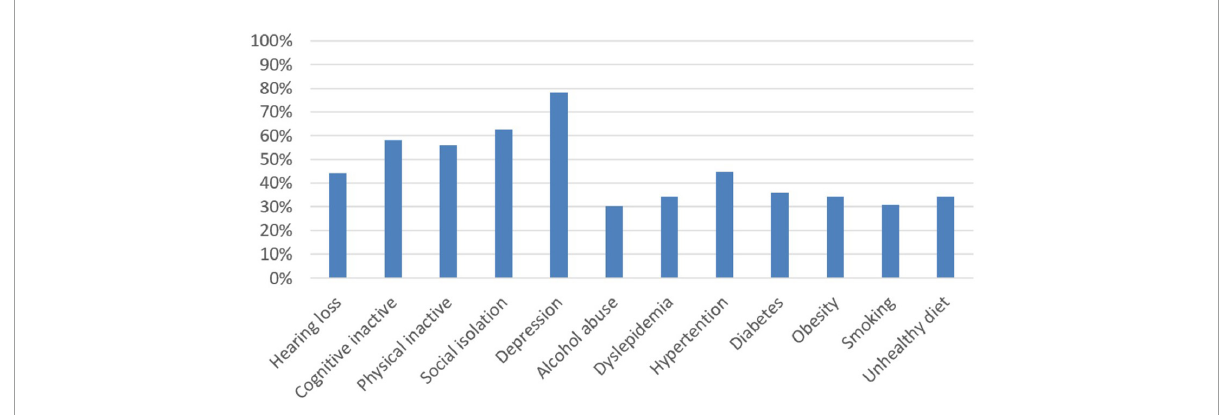
FIGURE1 Proportion of participants who identified each dementia risk factor.